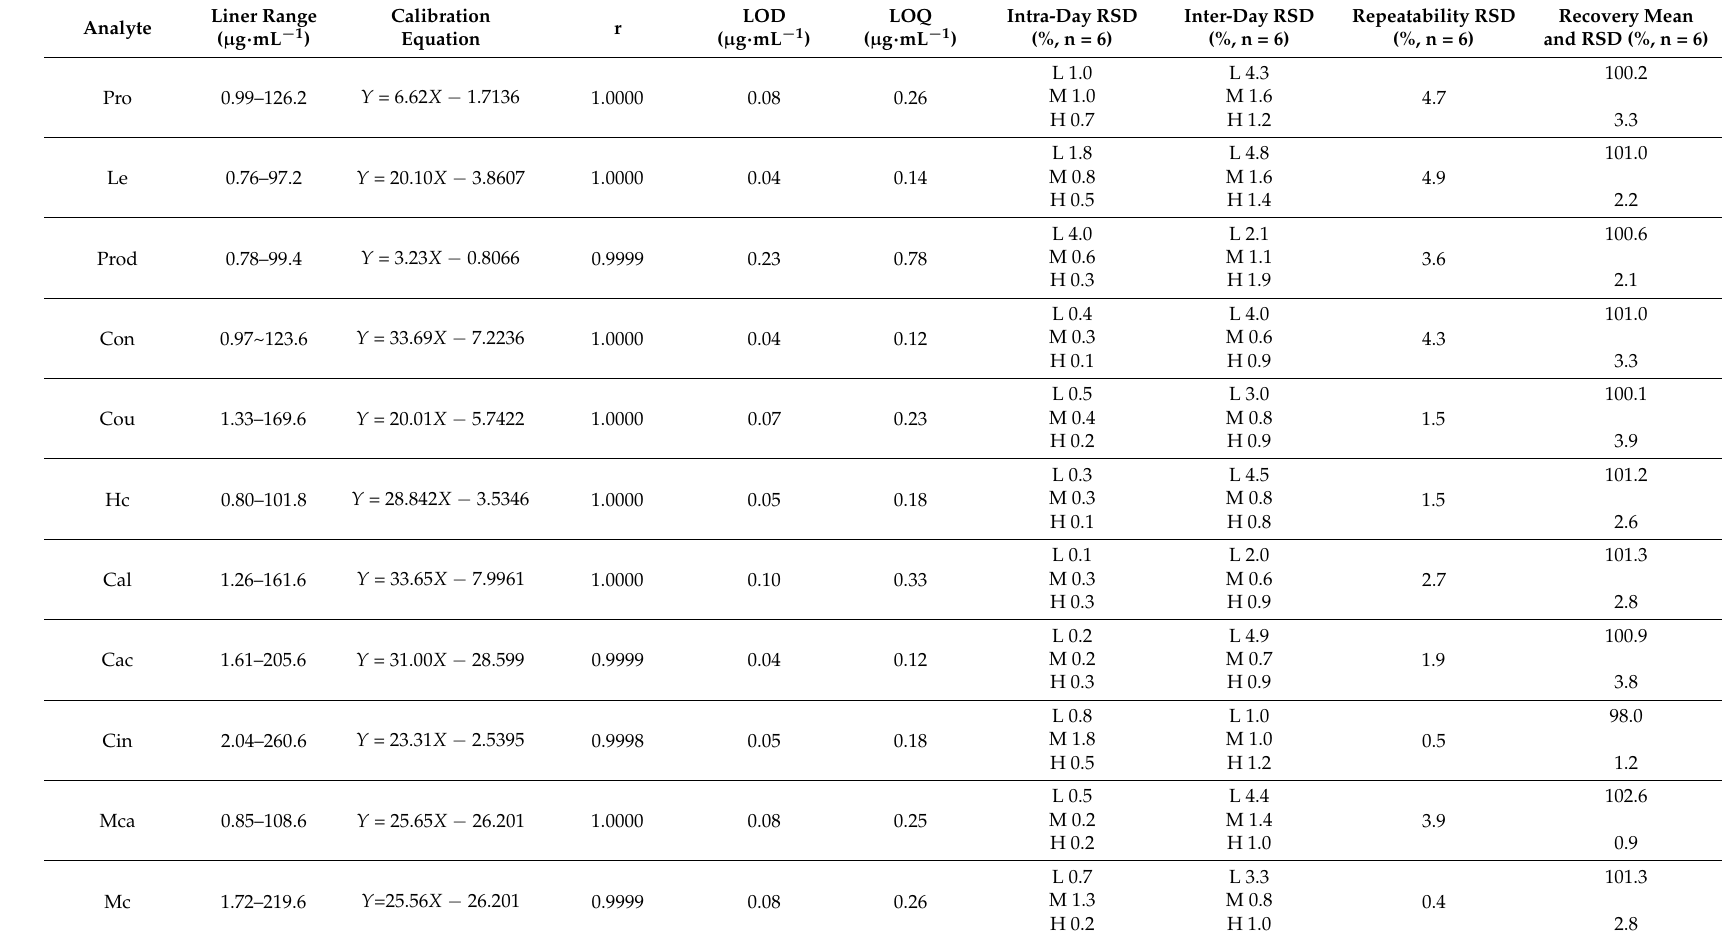
Table 2. Validation experimental data of 11 analytes in